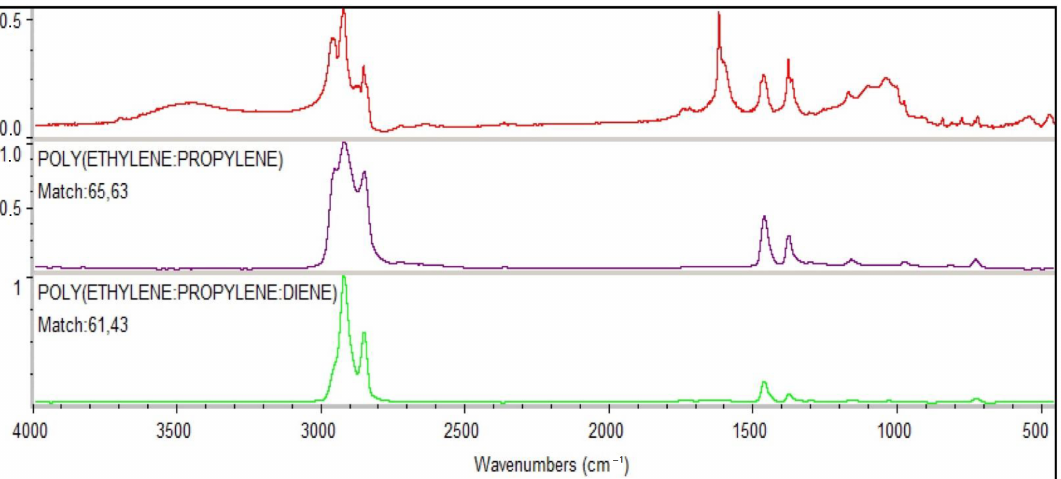
Figure 7. The appearance of the polymer type with the highest compatibility rating with the reference spectra displayed by the OMNIC 9